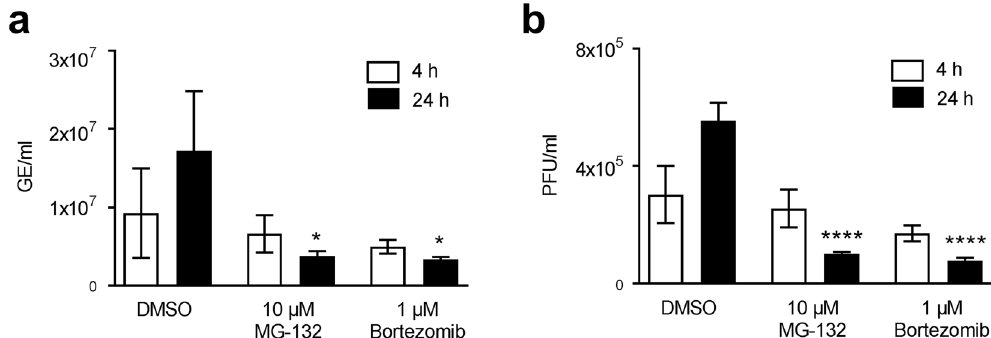
Figure 2. Proteasome inhibition leads to reduced CPXV genome equivalents and infectious particles. HeLa cells were infected with CPXV BR at an MOI of 1 in the presence or absence of 10 µ M MG-132 or 1 µ M Bortezomib. At 4 and 24 h post infection the amount of ( a ) viral genome equivalents (GE) and ( b ) plaque- forming units (PFU) in the supernatant was analyzed. Error bars indicate means ± standard deviation of one experiment performed in triplicate. Statistics: One-way ANOVA and Bonferroni’s multiple comparisons test ( * p ≤ 0.05, **** p ≤